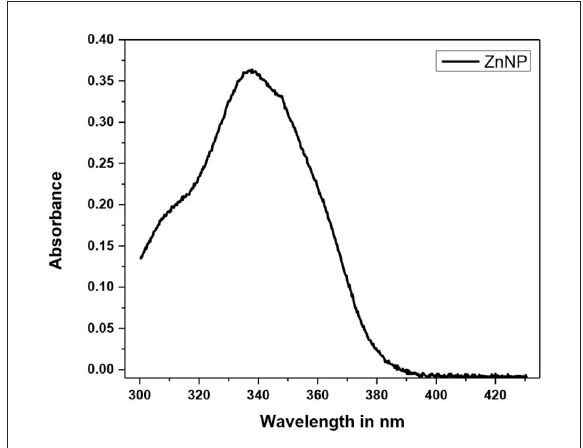
FIGURE4 UV–visible spectroscopic analysis Green synthesized ZnO NP.